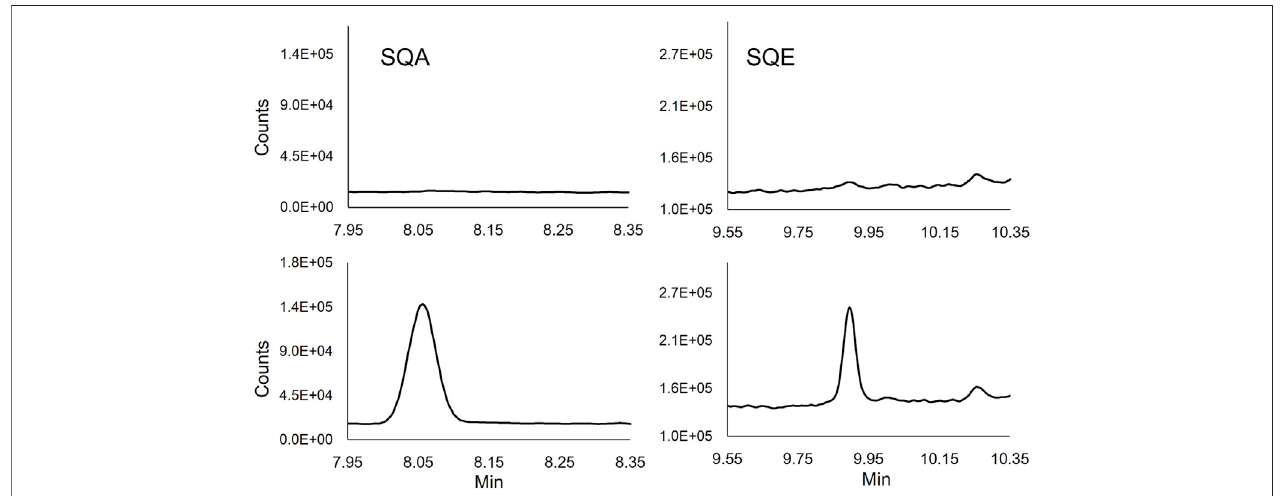
FIGURE1| ExtractedionchromatogramsofSQE(137 m/z)andSQA(113 m/z)quantifyingionsinunmodi fi ed(Topchromatograms)andspiked(1.5 μ g/ml)human BALF (Lower chromatograms).